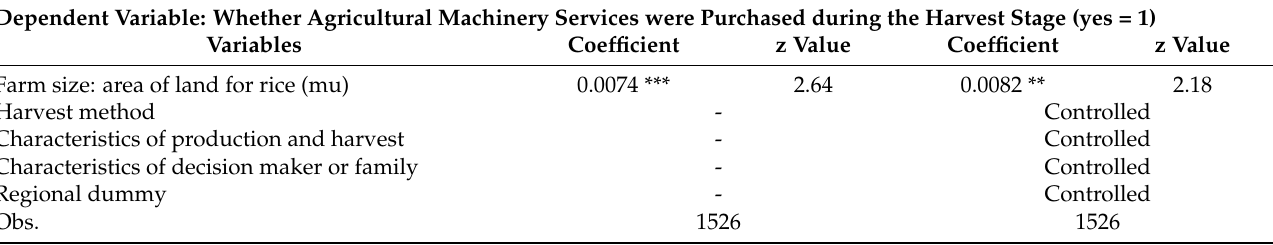
Table 6. Impact of farm size on the adoption of agricultural machinery services.